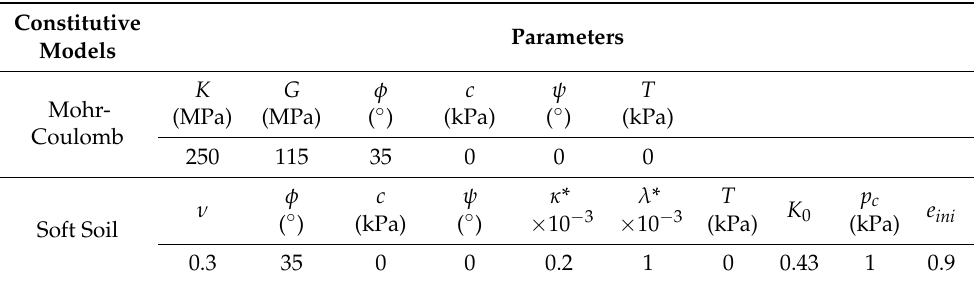
Table 3. Parameters of the Mohr–Coulomb and Soft Soil models applied for overlying uncemented backfill with unit weight γ = 18 kN/m 3 .